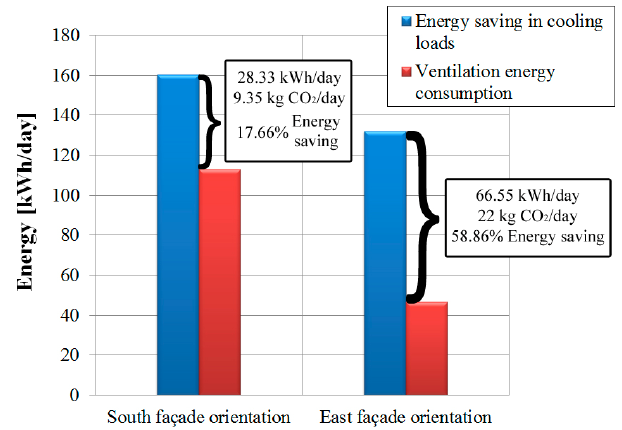
Figure 16. Energy savings using forced ventilation systems in DGF for south and east façade